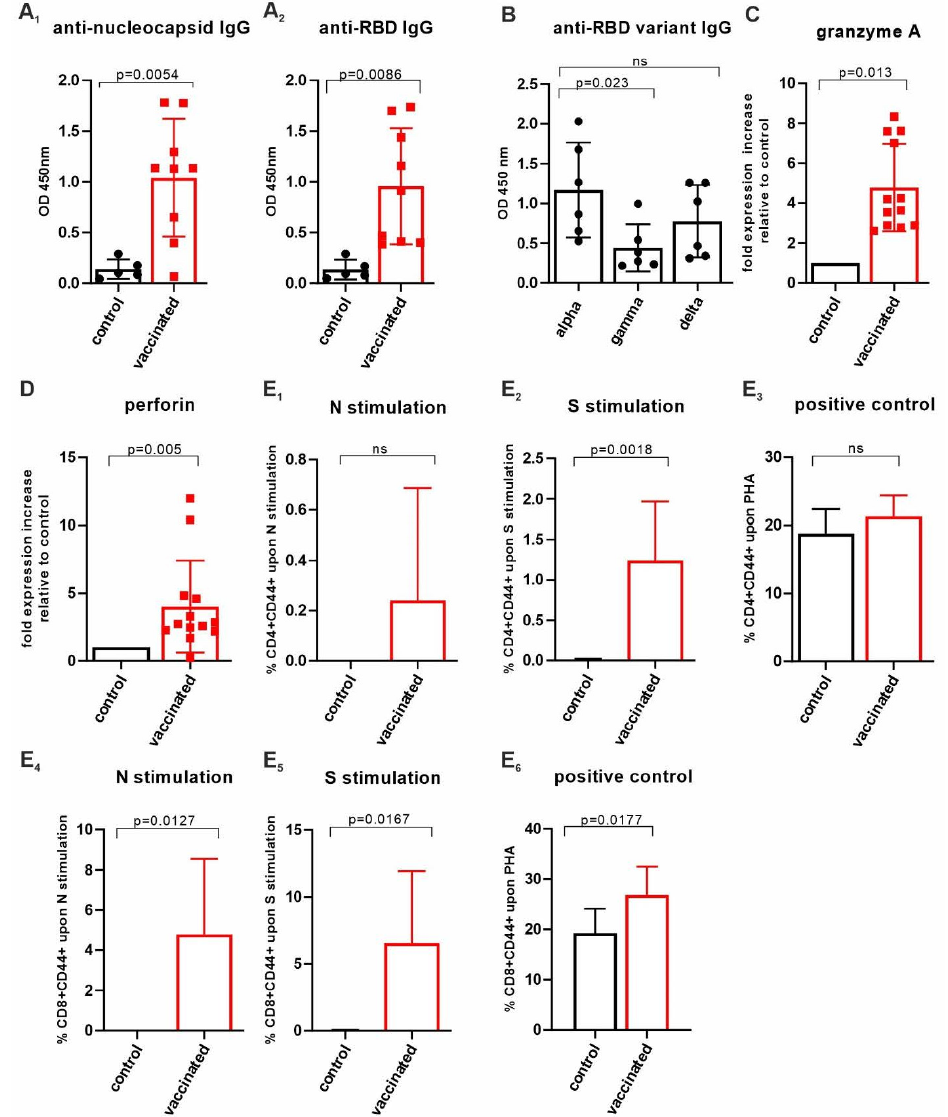
Figure 3. Assessment of cellular immunity upon AddaVax™/’VieVac’ administration. ( A 1 , A 2 ) AddaVax™/’VieVac’ immunization in prime-booster mode and IgG responses in 9 out of 13 mice. Control mice ( n = 5) received AddaVax™ only, and test animals received AddaVax™/’VieVac’ containing 10–40 µg protein. ( B ) Cross-reactivity against SARS-CoV-2 RBD variants, alpha vs. gamma and delta. Sera of n = 6 prime-booster-injected mice with AddaVax™/’VieVac’ were tested for IgGs recognizing alpha as compared to gamma and delta versions of the RBD. ( C , D ) Effector molecule gene expression in peripheral blood. Granzyme A ( C ) and perforin ( D ) expression in peripheral lymphocytes was evaluated by qPCR using a TaqMan probe set. Relative fold expression is indicated in 12 AddaVax™/’VieVac’ prime-booster-injected mice in relation to the mean of n = 5 control mice that had received AddaVax™ adjuvant only. ( E 1 – E 6 ) CD4 + and CD8 + T-cell responses in ex vivo-stimulated spleen cells. CD4 + T cells ( E 1 – E 3 ) were stimulated ex vivo with N-specific ( E 1 ) and S-specific peptides ( E 2 ) or PHG ( E 3 ). Control mice ( n = 5, adjuvant only) were compared to vaccinated mice ( n = 13, AddaVax™/’VieVac’). CD8 + T cells ( E 4 – E 6 ) were stimulated ex vivo with N-specific ( E 4 ) and S-specific peptides ( E 5 ) of PHA ( E 6 ). Control mice ( n = 5, adjuvant only) were compared to vaccinated mice ( n = 13, AddaVax™/’VieVac’).